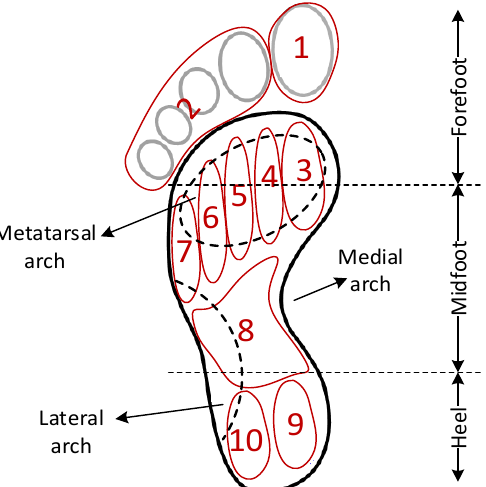
Figure 1. Representation of the footprint division into three regions: forefoot, midfoot and heel, with the illustration of the ten anatomical areas accountant for the derivation of lower-limb and whole-body physiological, structural and functional information.